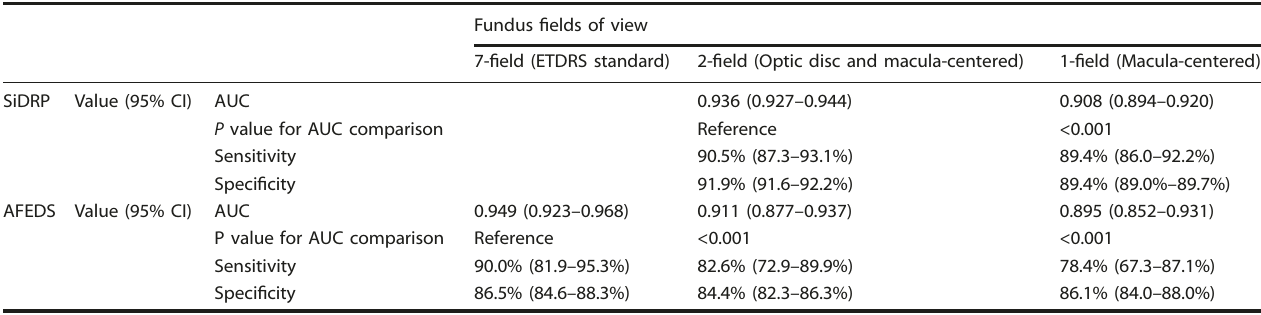
Table 5. Effect of image-related factors speci fi cally fundus fi elds of